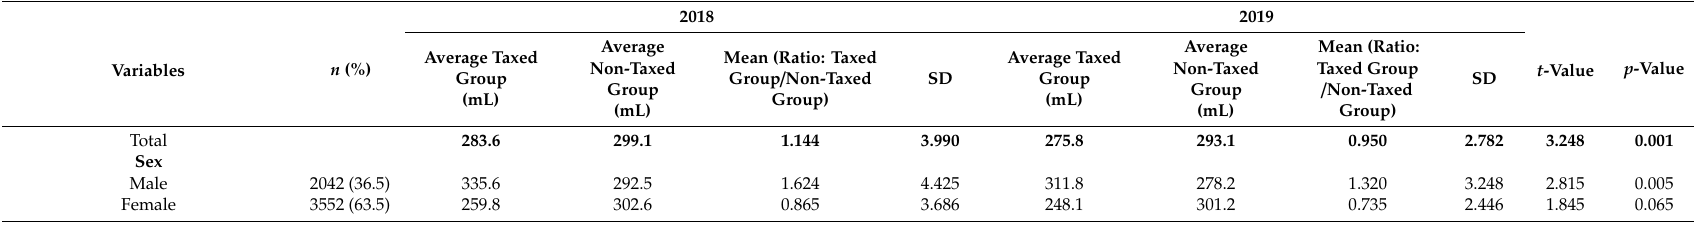
Table 4. Significance of the di ff erence in ratio of average taxed to non-taxed SSBs consumed between 2018 and 2019, by sociodemographic characteristics ( n = 5594).